Question: Briefly state, in one sentence, what is plotted here.
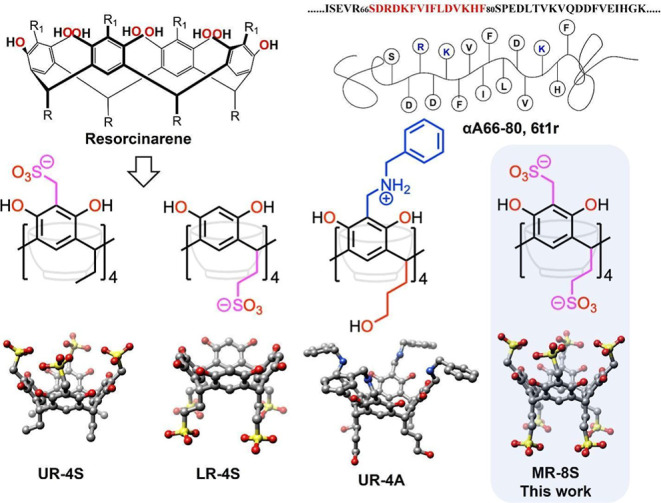
Answer: Structure of the αA66–80 Crystallin peptide chain and DFT-optimized geometries of functionalized polyionic macrocycles: upper-rim tetrasulfonated resorcinarene ( UR-4S ), lower-rim tetrasulfonated resorcinarene ( LR-4S ), upper-rim N -benzyl ammonium resorcinarene chloride ( UR-4A ), and mixed-rim octasulfonated resorcinarene ( MR-8S ). Macrocycle structures were optimized at the B3LYP /6–31G­(d,p) , level of theory. Atom color scheme: carbon, gray; nitrogen, blue; oxygen, red; sulfur, yellow; hydrogen atoms are omitted for clarity.